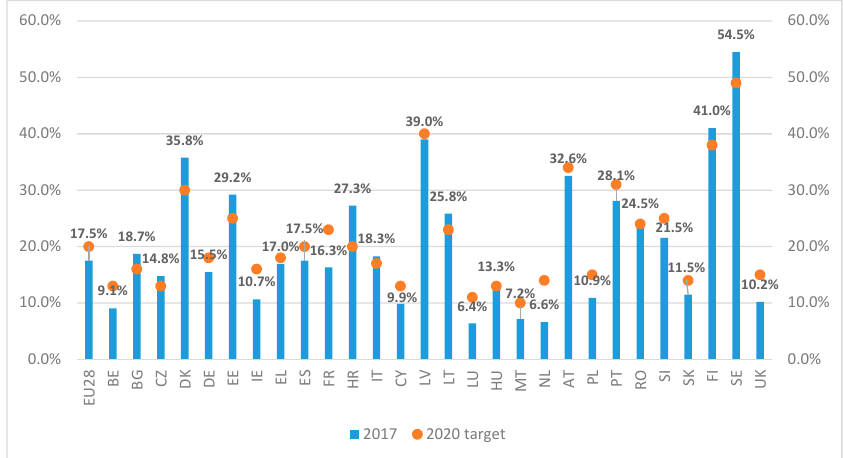
Figure 2. Share of renewable energy in the EU in 2017 and 2020 target. Source: own computations performed on data retrieved from Eurostat [18].